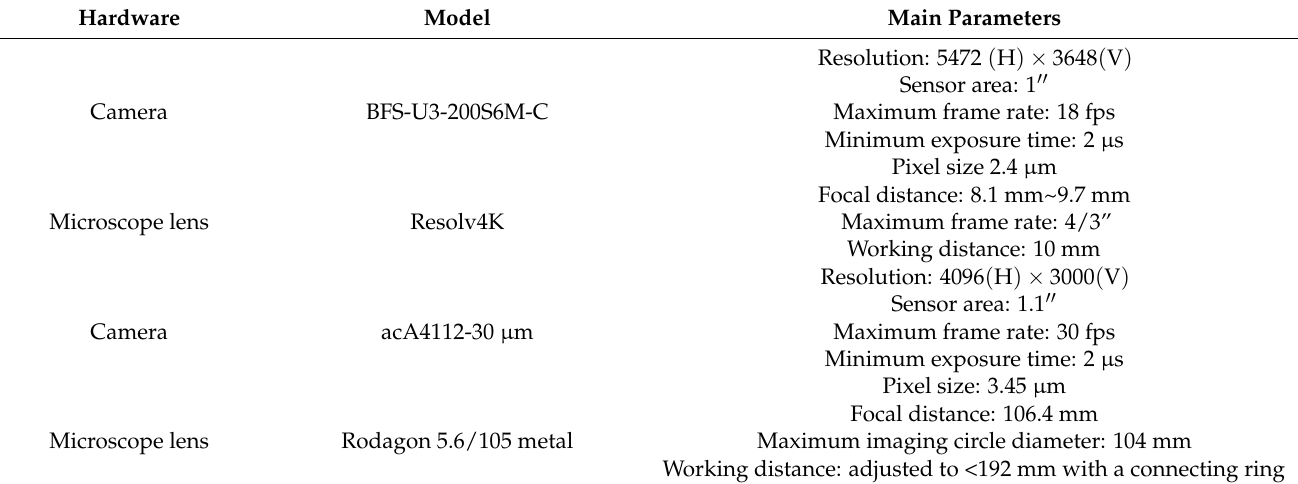
Table 2. Main hardware parameters.